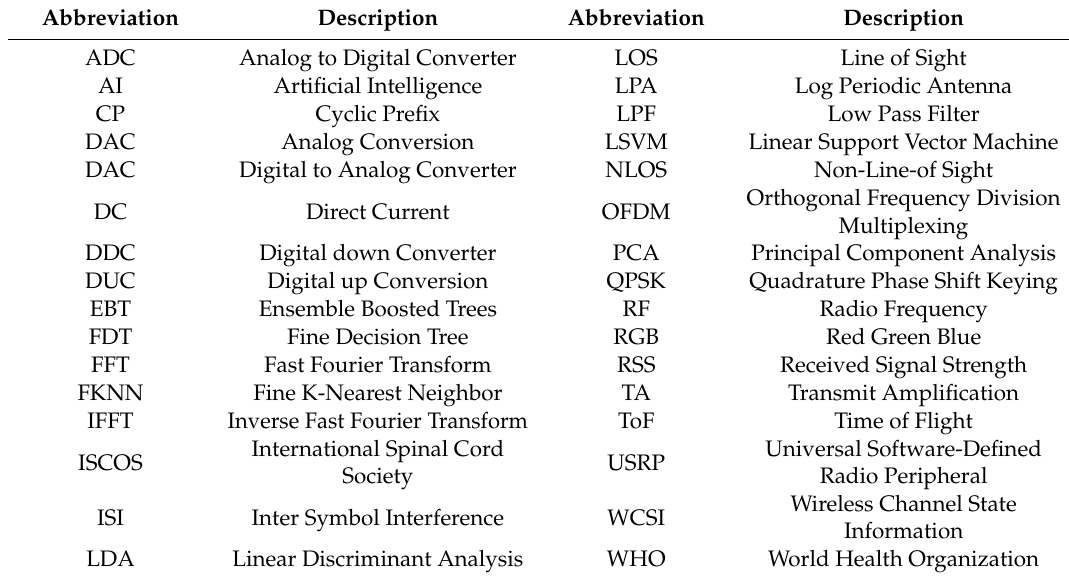
Table 1. List of used